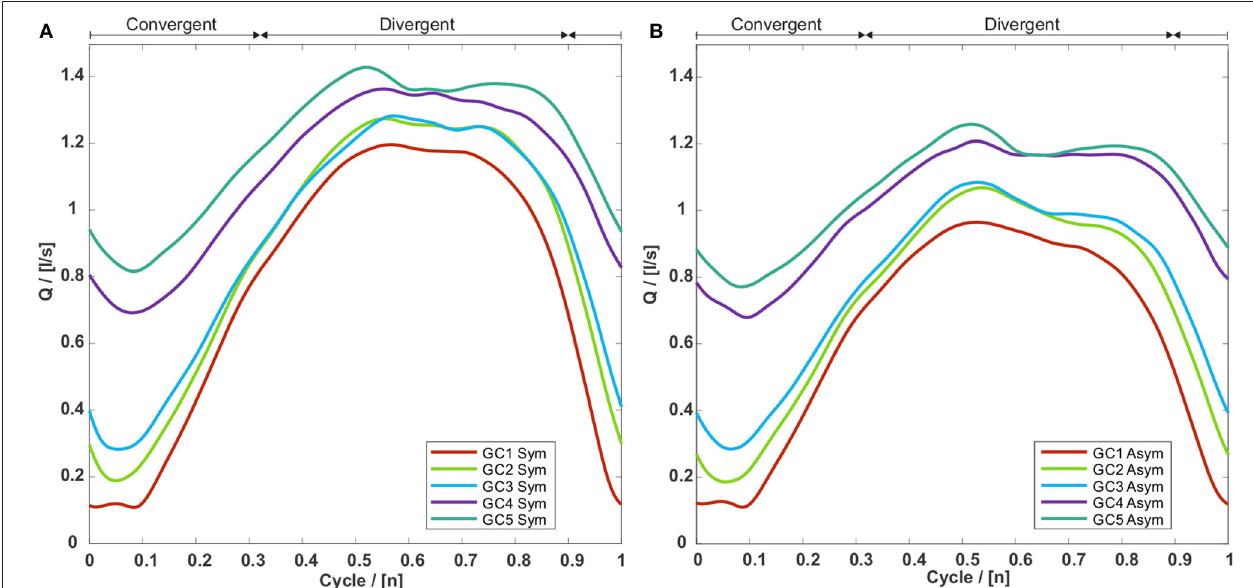
FIGURE 6 | Volume flow through the glottis for the five GC types with (A) a symmetric and (B) an asymmetric vocal fold motion. For both motion types the volume flows are rising with an increasing glottal insufficiency, whereas the corresponding volume flows of the asymmetric motion are collectively smaller than those of the symmetric motion.